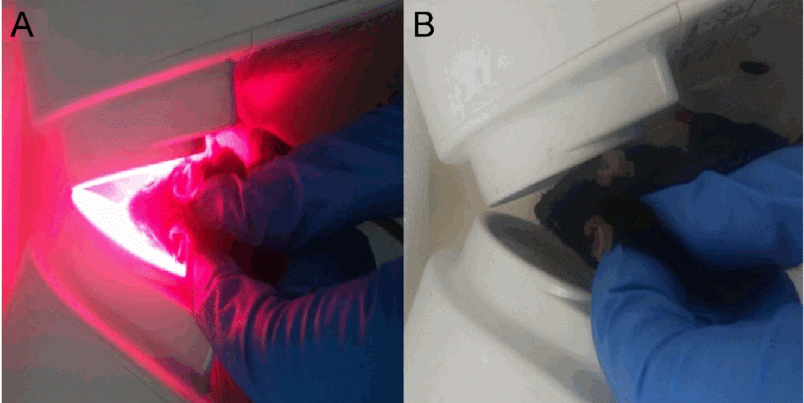
Figure 8. Irradiation procedure. ( A ) Light-treated mice were scruffed in front of two WARP 10 light devices for 88 s, positioned as shown, to ensure that an irradiance of approximately 50 mW/cm 2 reached the cornea. ( B ) Sham-treated mice were scruffed in front of the light source for 88 s to ensure the level of stress was uniform throughout the experimental